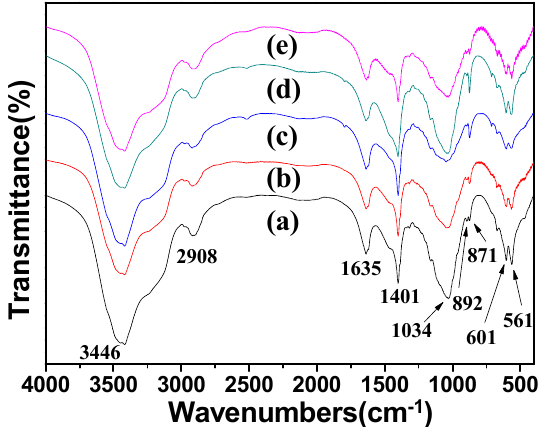
Figure 3. Fourier-transform infrared (FT-IR) spectra of the cellulose/HA nanocomposites prepared by microwave-assisted hydrothermal method at 150 °C for 10 min ( a , c – e ) and 60 min ( b ) using different phosphorus sources: ( a , b ) NaH 2 PO 4 · 2H 2 O; ( c ) ATP; ( d ) CP; ( e )